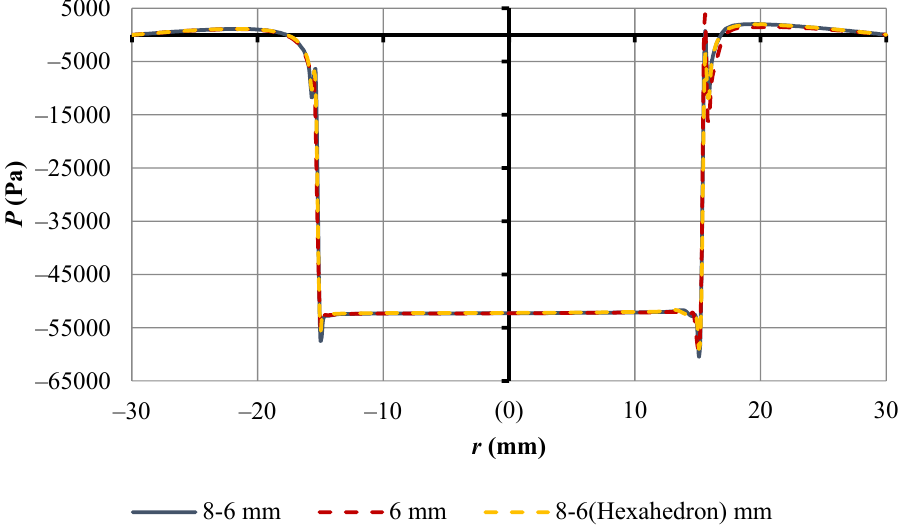
Figure 10. Dependence of air pressure distribution on the surface of an OM at different parameters of the geometry of the narrowing of the fitting.